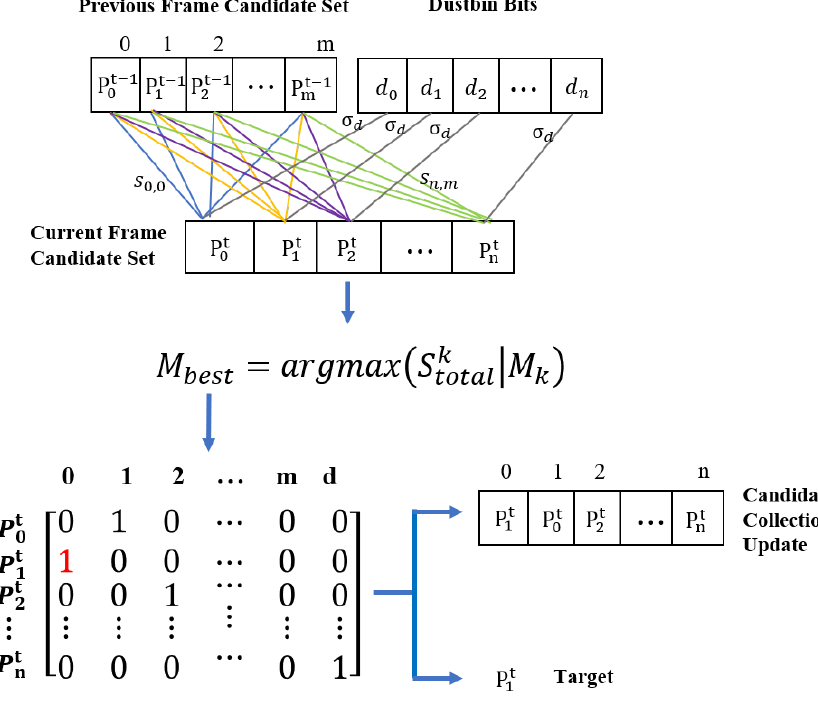
Figure 4. Target localization